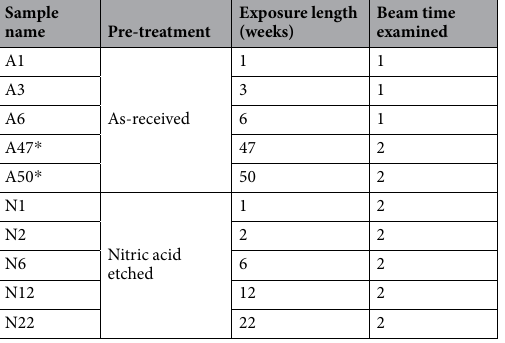
Table 1. A summary of the 8 uranium metal samples including the sample name, type of metal surface pre- treatment, water vapour exposure length and the beam time examined. The sample names preceding with an A (Group A) received no previous surface preparation so were considered the as-received samples. Sample names preceding with an N (Group N) received nitric acid etching prior to grout encapsulation. * The two samples A3 and A6 were re-analysed on the second beam time after further exposure to water vapour. These were then renamed A47 and A50